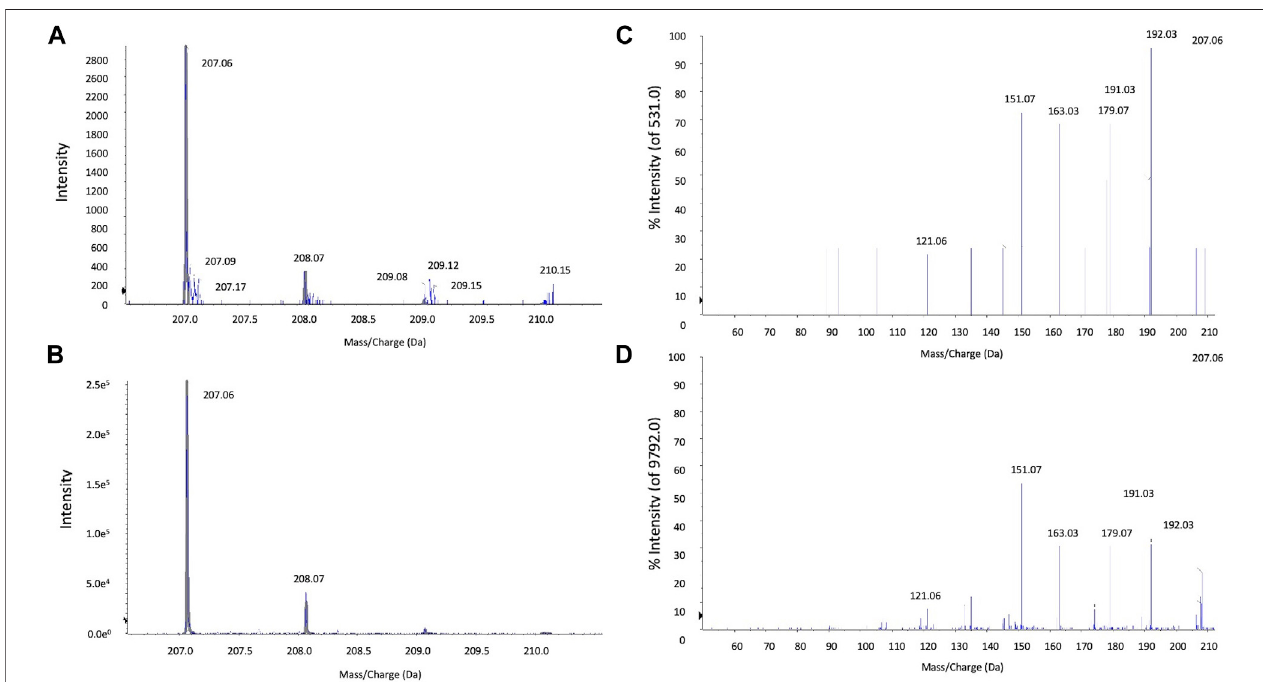
FIGURE3| LC-MS/MSanalysisofextractsofArtemisiacapillaris. ThemajorHPLCpeak(5.4 min)fromextractsof Artemisiacapillaris andthestandardcompound 6,7-dimethylesculetin were subjected to tandem mass spectrometry. Primary isotope mass spectrometry of Artemisia capillaris extract and 6,7-dimethylesculetin (Panels (A) and (B) respectively) and the secondary mass spectrum of Artemisia capillaris extract and 6,7-dimethylesculetin (Panels (C) and (D) respectively) from precursor 207.1 Da are shown.